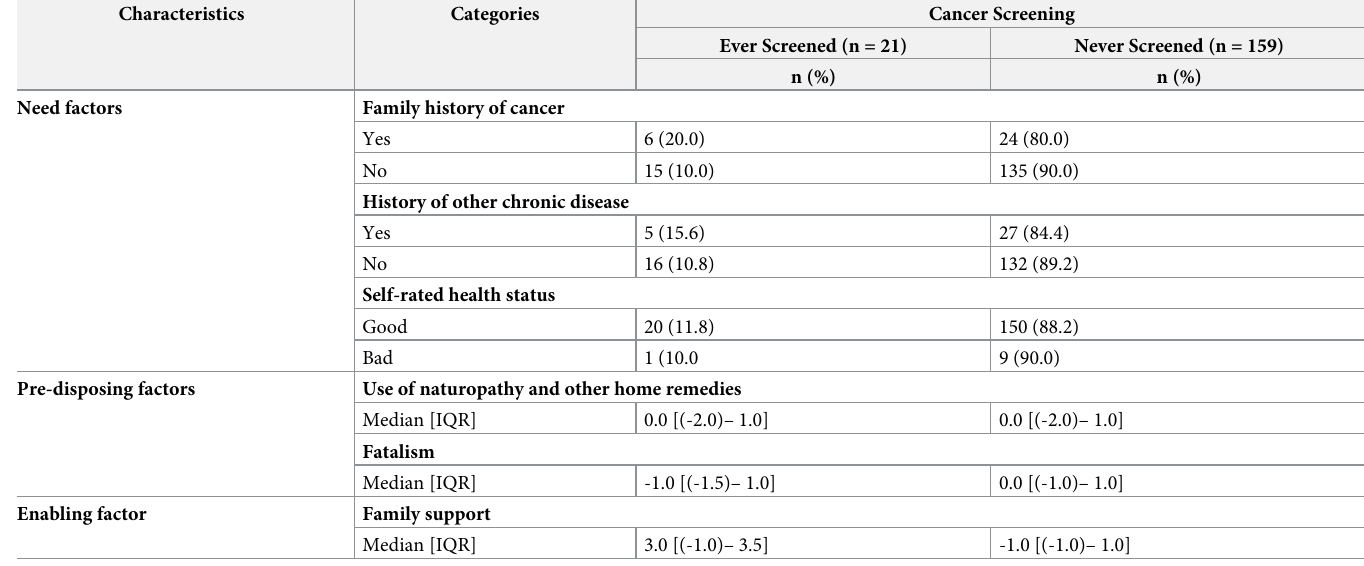
Table 2. Need, pre-disposing and enabling factors of cancer screening behaviour among the study participants (n = 180).